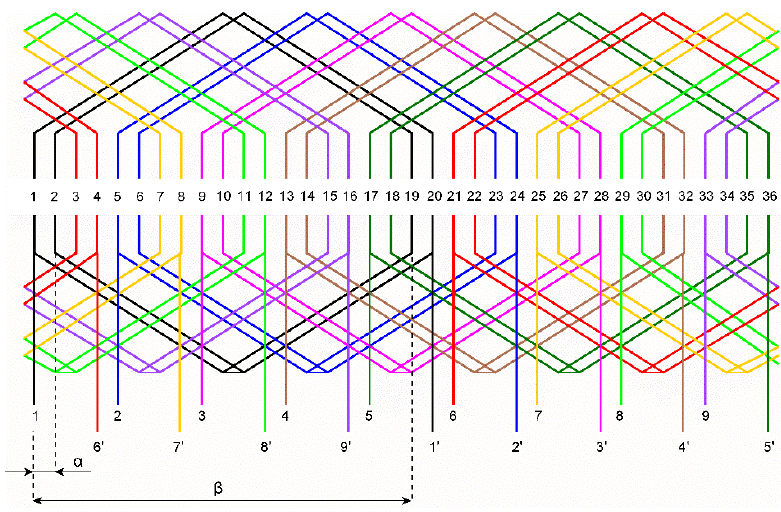
Figure 6. Arrangement of the second type of nine-phase winding ( S = 2, M = 9, c g = 2, α = 360/ Z s = 360/36 ≈ 10°, β = 18 α = 180°); beginnings of the phase windings: 1, 2, 3…; endings of the phase windings: 1 ′ , 2 ′ , 3 ′ , …